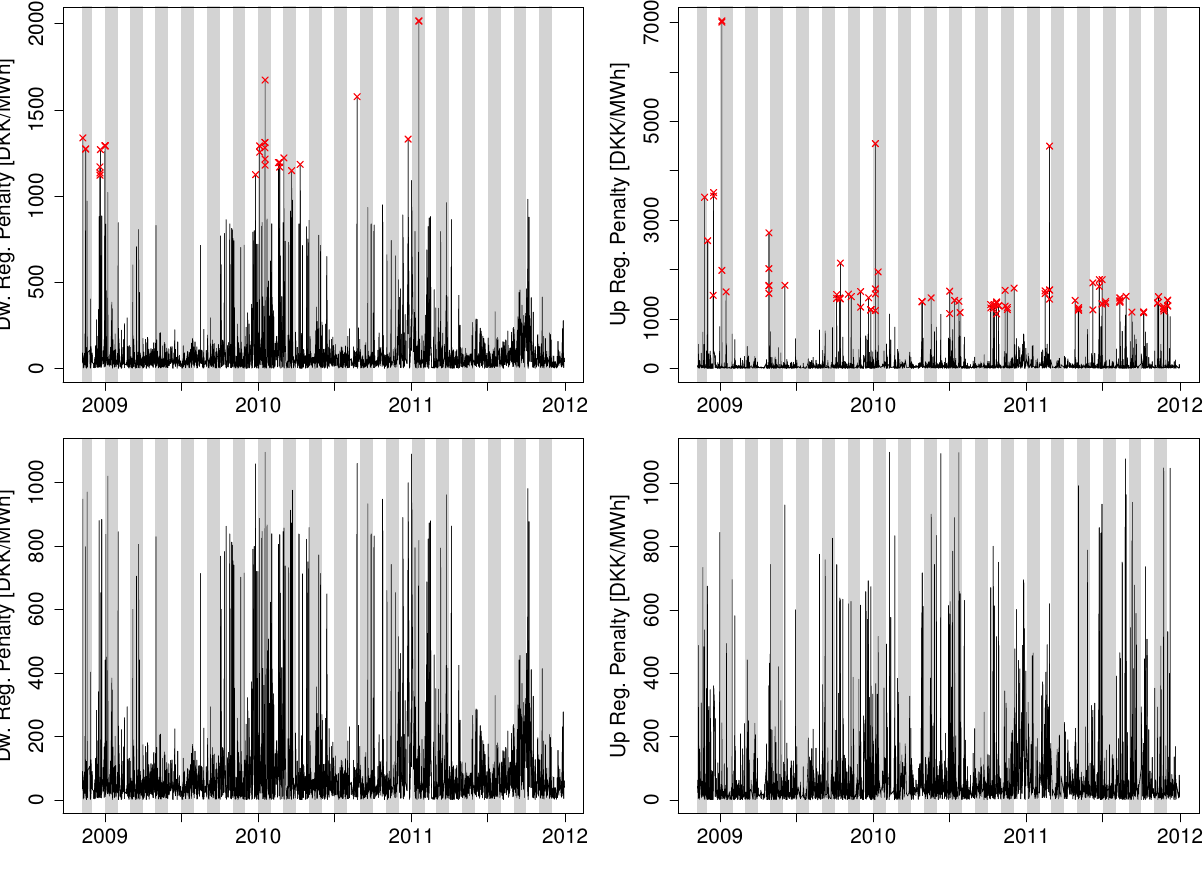
Figure 1. Time series plot of the down- and up-regulation penalties ( left and right , respectively) with the excluded observations marked.